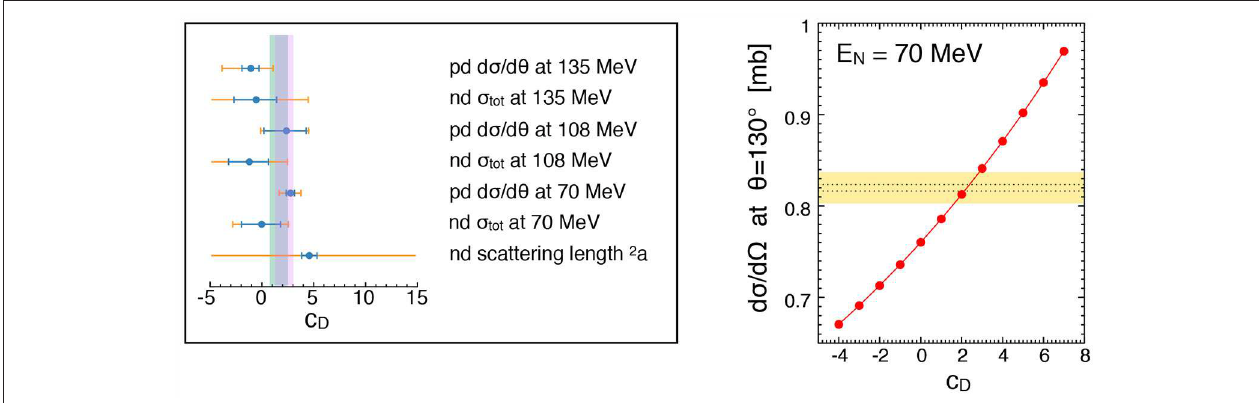
FIGURE 10 | (Left) Determination of the LEC c D at N 2 LO from selected Nd scattering observables. The smaller (blue) error bars correspond to the experimental uncertainty while the larger (orange) error bars also take into account the truncation error at N 2 LO estimated using the EKM approach of Epelbaum et al. [21]. The green (violet) bands show standard error intervals of c D resulting from a combined least squares single-parameter fit to all observables (to observables up to E N 108 MeV) using the orange error bars. (Right) Nd cross section in the minimum region ( θ 130 ◦ ) at E N 70 MeV as function of the LEC c D . For each c D value, = = = the LEC c E is adjusted to the 3 H binding energy. Dotted lines show the statistical uncertainty of the experimental data from Sekiguchi et al. [184], while the yellow band also takes into account the quoted systematic uncertainty of 2 % . All results are obtained using the N 2 LO SCS NN potential from Epelbaum et al. [ 21] in combination with the N 2 LO SCS 3NF for the coordinate-space cutoff R 0.9 fm. =